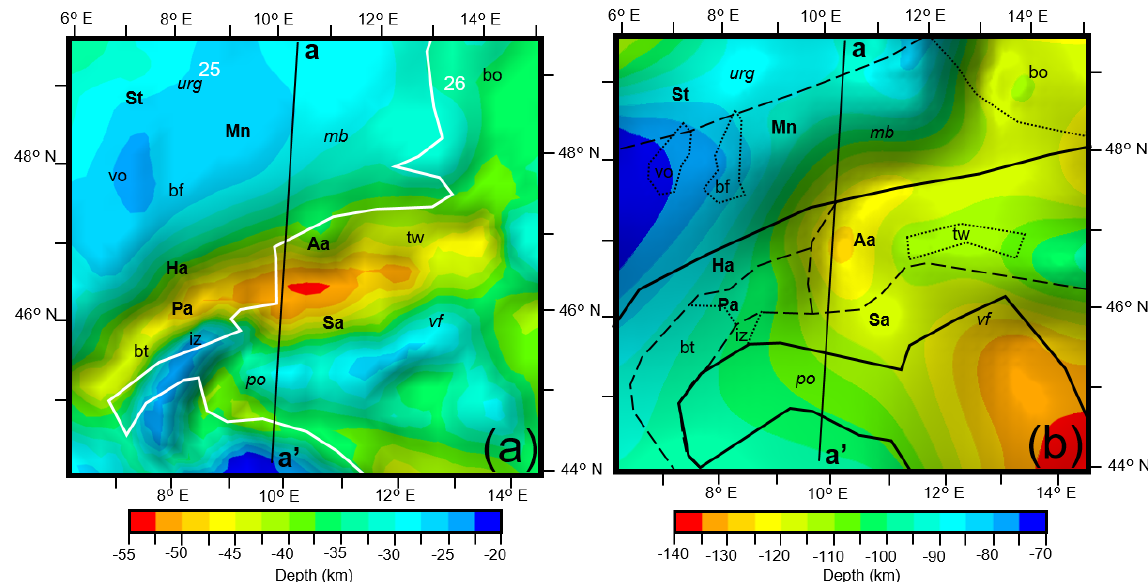
Figure 5. (a) Depth to the Moho across the modelled area. Density domains required during modelling within the lithospheric mantle are overlaid in white; domain numbers are shown in white and correspond to Table 1. (b) Depth to the LAB from Geissler et al. (2010) across the modelled area. Locations of key tectonic features are overlaid for both figures (definitions shown in Fig. 1a caption).